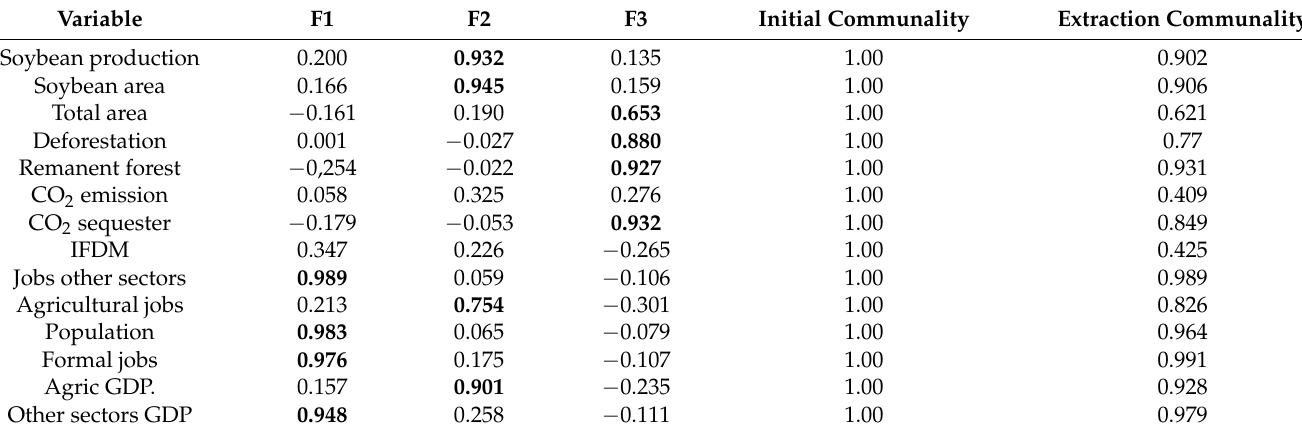
Table 6. Factorial charges and